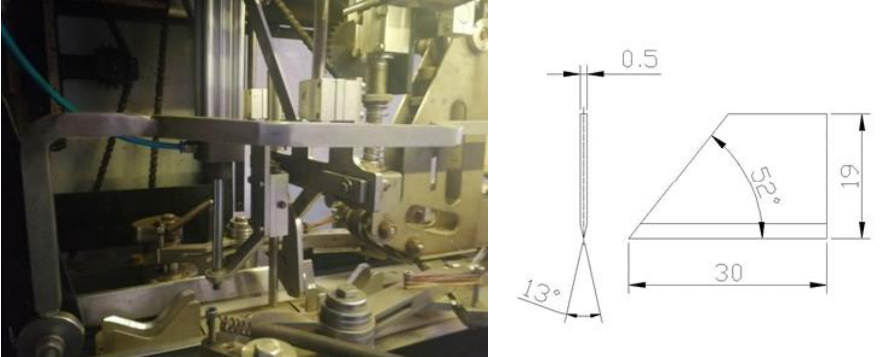
Figure 7. Cutting system of the external surface with the marking of geometrical dimensions of cutting knives (5).